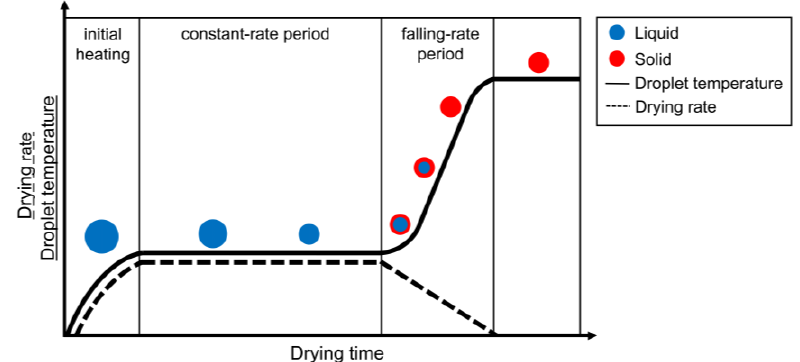
Figure 1. Schematic illustration of the different stages a droplet experiences during the drying process. Temperature evolution is represented by a solid line and drying rate by a dotted line. The liquid fraction is shown in blue and the solid fraction in red (modified from Mezhericher et al. [11,13]).